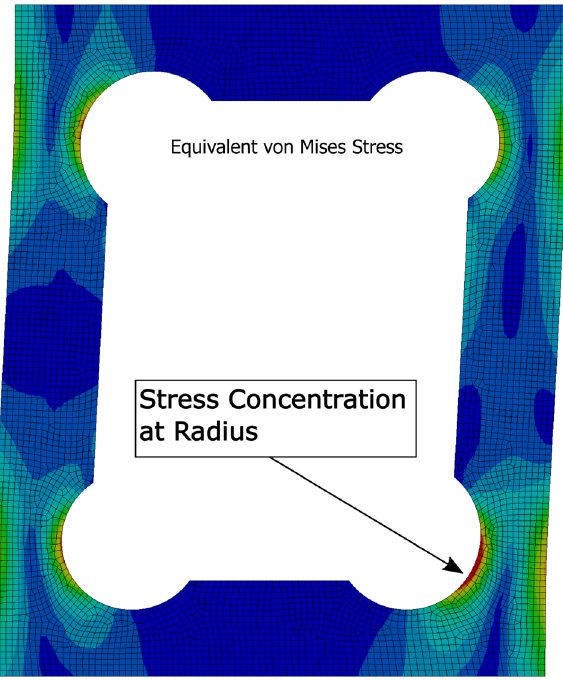
Figure 1. Stress concentration in a thermal cut radius of a typical opening in a ship structure.